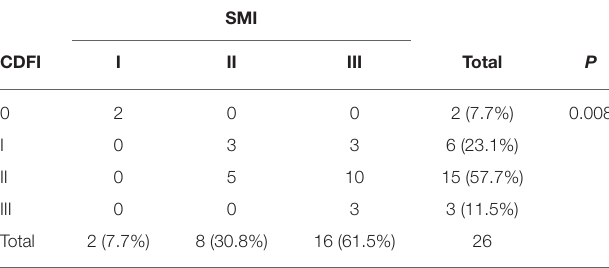
TABLE 2 | Blood flow characteristics and differences between SMI and CDFI.